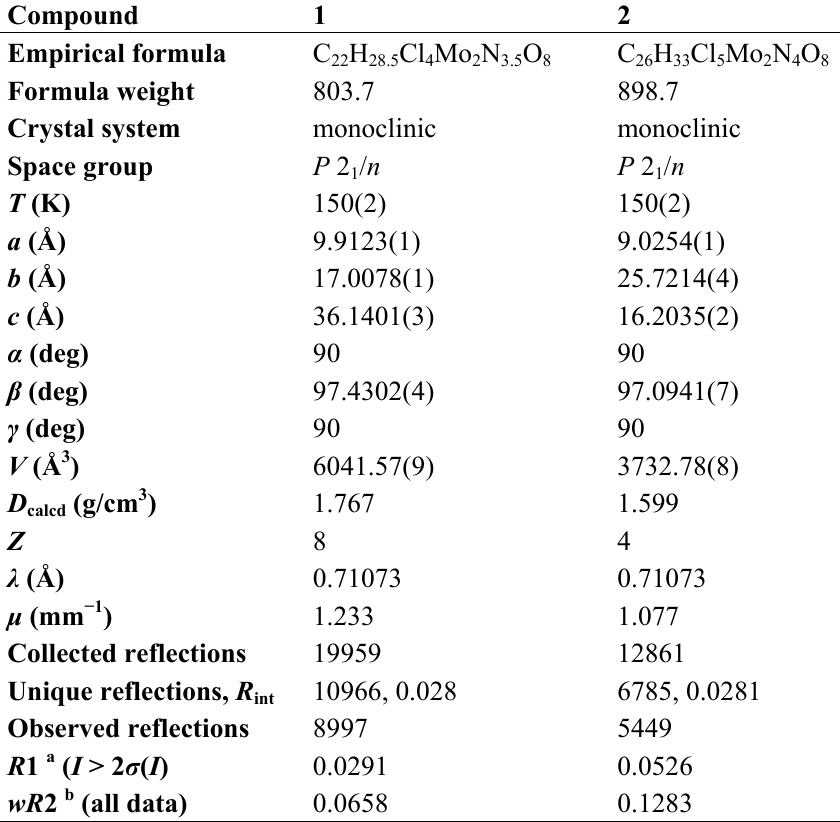
Table 5. Crystallographic data for 1 and 2